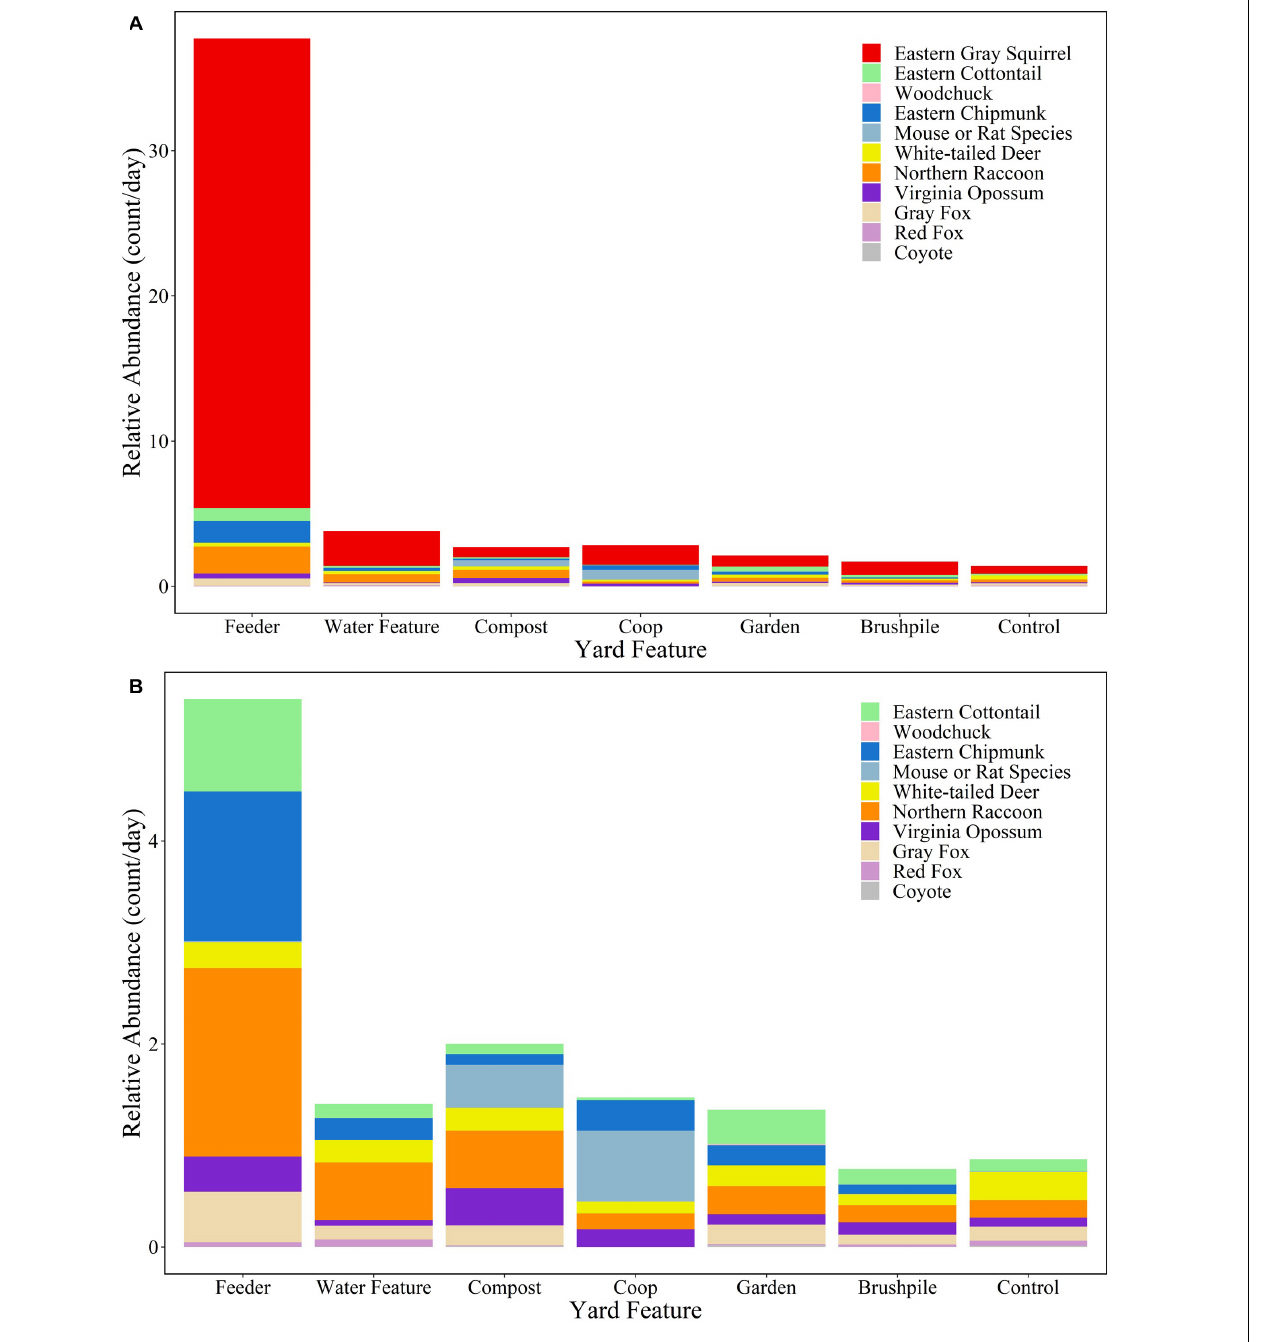
Top-down forces (i.e., predation) can play a large role in population fluctuations of species at lower trophic levels (e.g., Hairston et al., 1960) through density- or trait-mediated processes (Abrams et al., 1996); however, we did not find